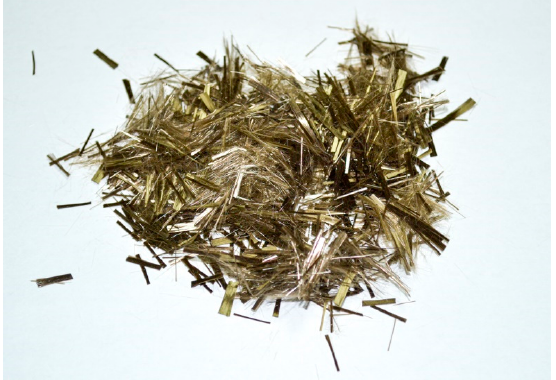
Figure 3. Basalt fiber (scale 1:1).